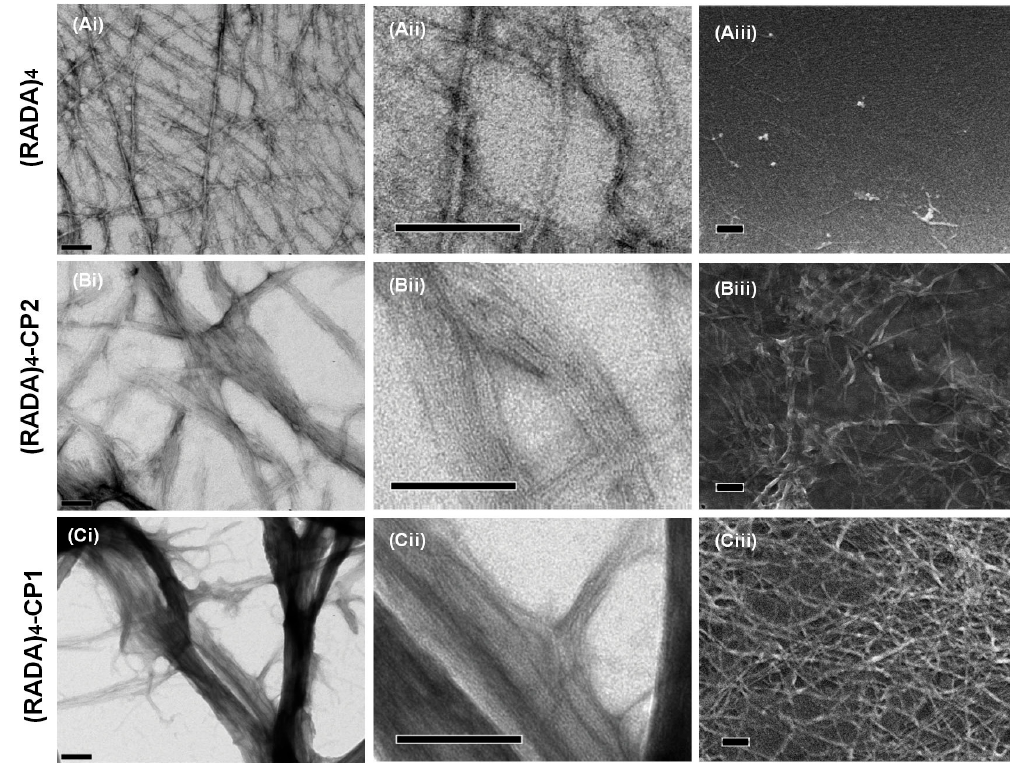
Figure 2. Electron microscopy of ( A ) (RADA) 4 , ( B ) (RADA) 4 ‐ GG ‐ GPQG+IASQ (CP1), and ( C ) (RADA) 4 ‐ GG ‐ GPQG+PAGQ (CP2). Low ( i ) and high ( ii ) magnification using transmission electron